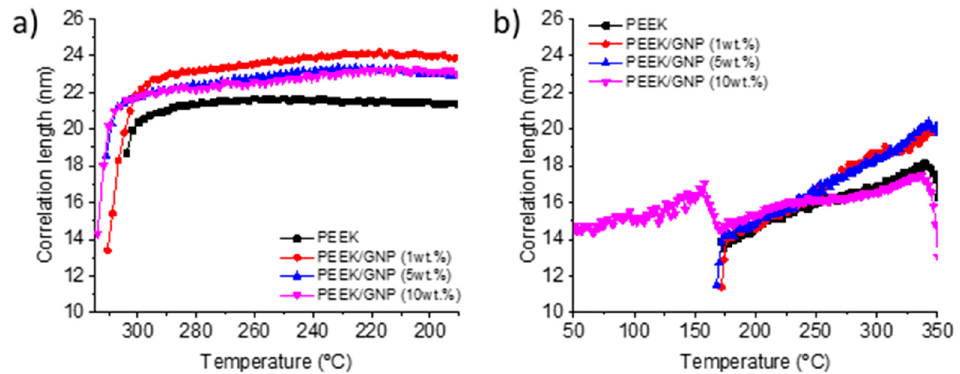
Figure 8. Temperature dependence, on cooling from melt ( a ) and heating from glass ( b ) of the correlation length of (110) reflection peak for all samples.